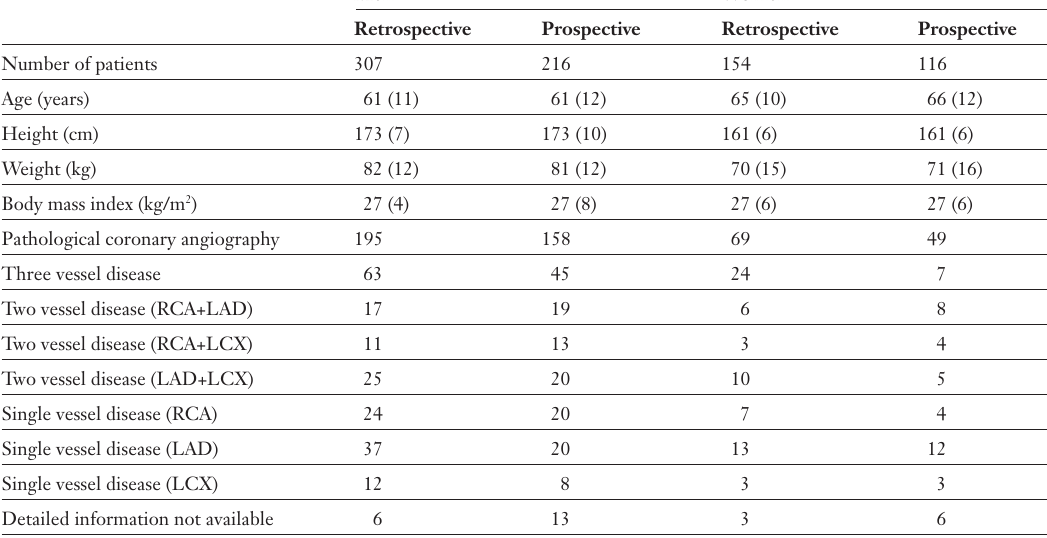
Values are given as mean (standard deviation). For coronary angiography results, numbers of patients are given. Left main artery stenosis was counted as two vessel disease. RCA: right coronary artery. LAD: left anterior descending coronary artery. LCX: left circumflex coronary artery.